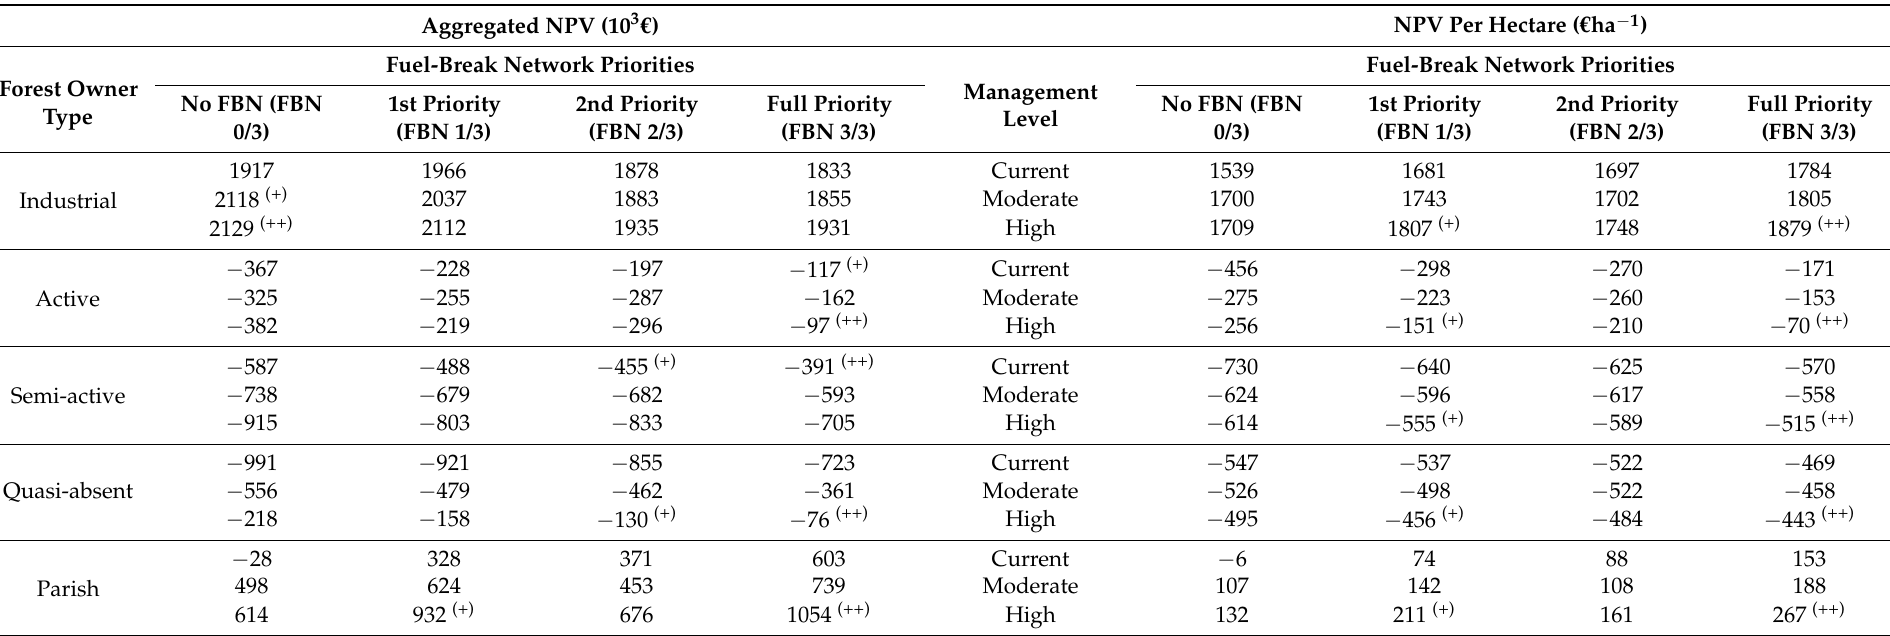
Table A3. Aggregated and per ha net present value (NPV) for all the fire scenarios and owner types; the best and second best scenarios by owner type/parish are marked with (++) and (+),